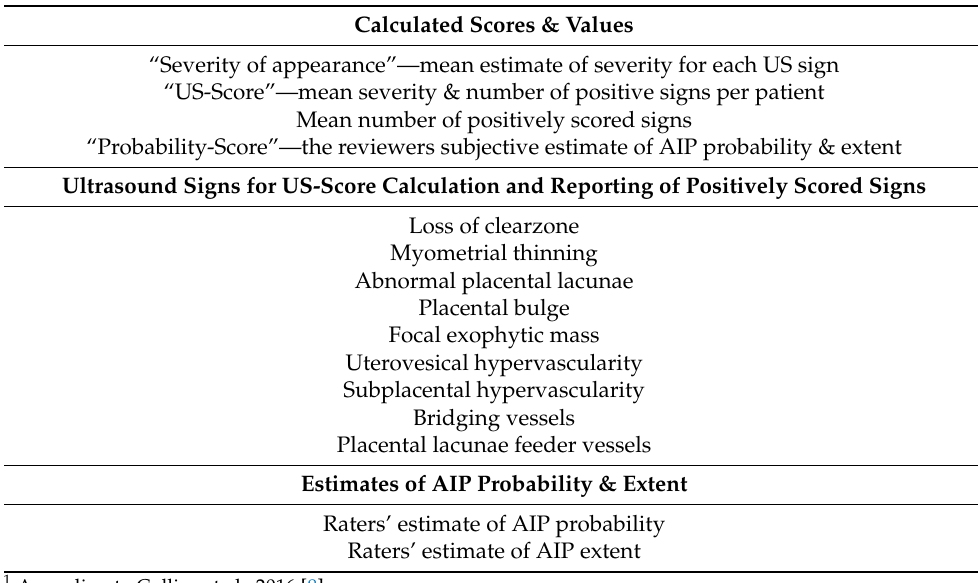
Table 1. Calculated scores and the list of evaluated US signs 1